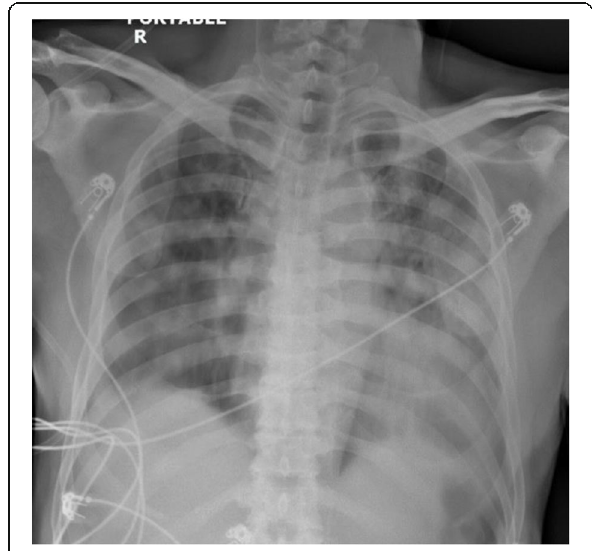
Fig. 1 Chest X-ray showing bilateral lower zone peripheral opacities